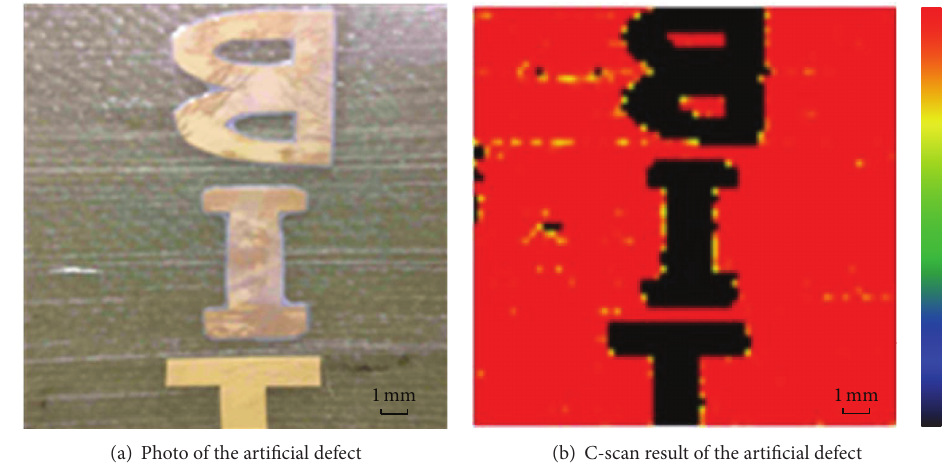
Figure 8: C-scan image of the ultrasonic testing